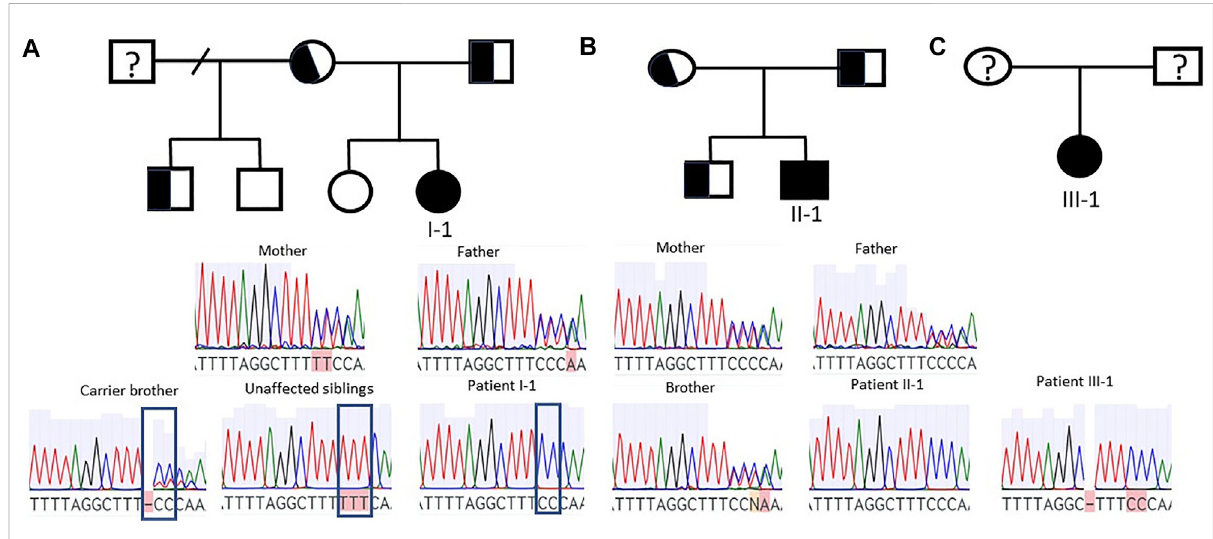
FIGURE 1 Segregation of CFAP300 mutations. Patients I-1 and II-1 were homozygous for the mutation while parents were heterozygous. (A) . Patient I-1 family with carrier parents and one carrier brother and two unaffected siblings. The mutation siteis indicated in carrier and unaffected siblings and in patient I-1. (B) . Patient II-1 family with carrier parents and brother. (C) . Sanger sequencing result for patient